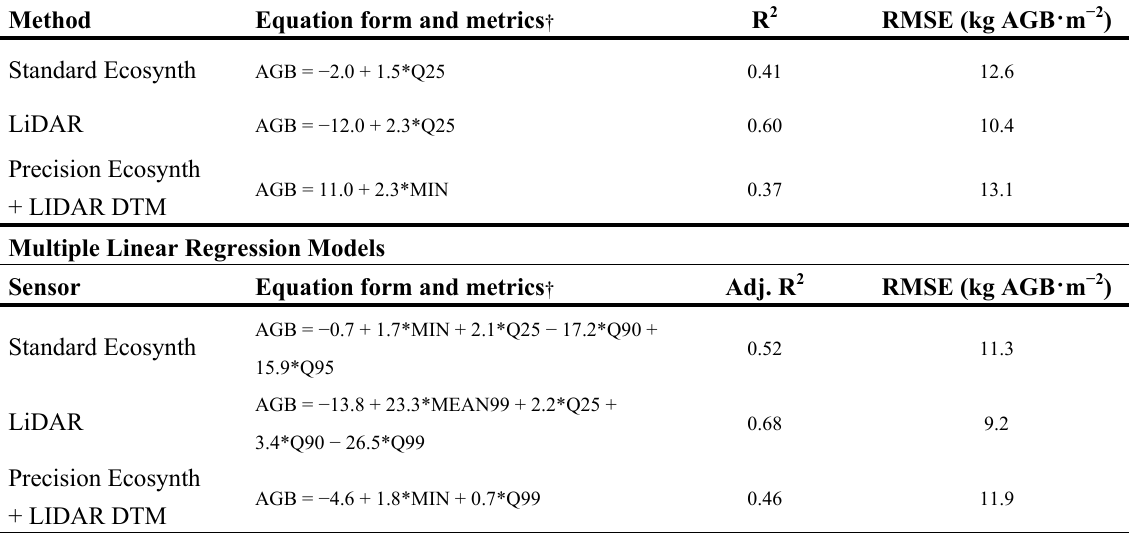
Table 3. Regression models predicting aboveground biomass (AGB) from Ecosynth and LiDAR CHM height metrics across 25 m subplots at the Knoll site. Results of simple linear regression represent the single metric model with the highest R 2